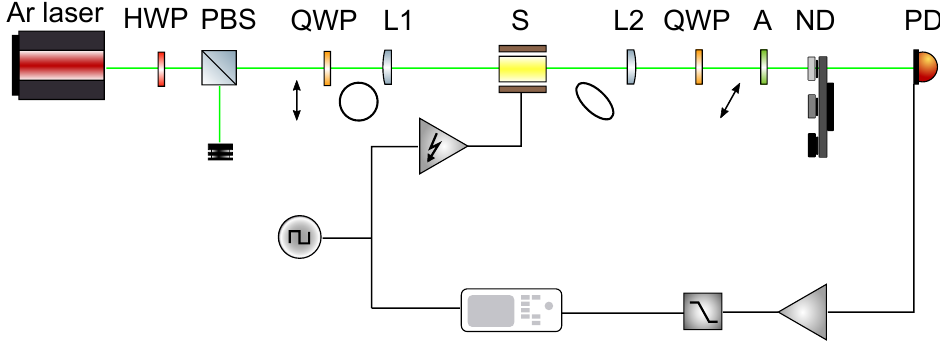
Figure 1. Simplified scheme of the setup. The elements composing it are: half waveplate (HWP); polarizing beamsplitter (PBS); quarter wave plate (QWP); lens f = 250 mm (L1); sample (S); lens f = 60 mm (L2); analyzer (A); neutral density filter wheel (ND); photodiode (PD). The sample is placed inside the Rayleigh range of the beam created by the lens L1, while the lens L2 images the output face of the sample on the photodiode. The arrows, circle and ellipse indicate the polarization state of the beam along the Tardy’s